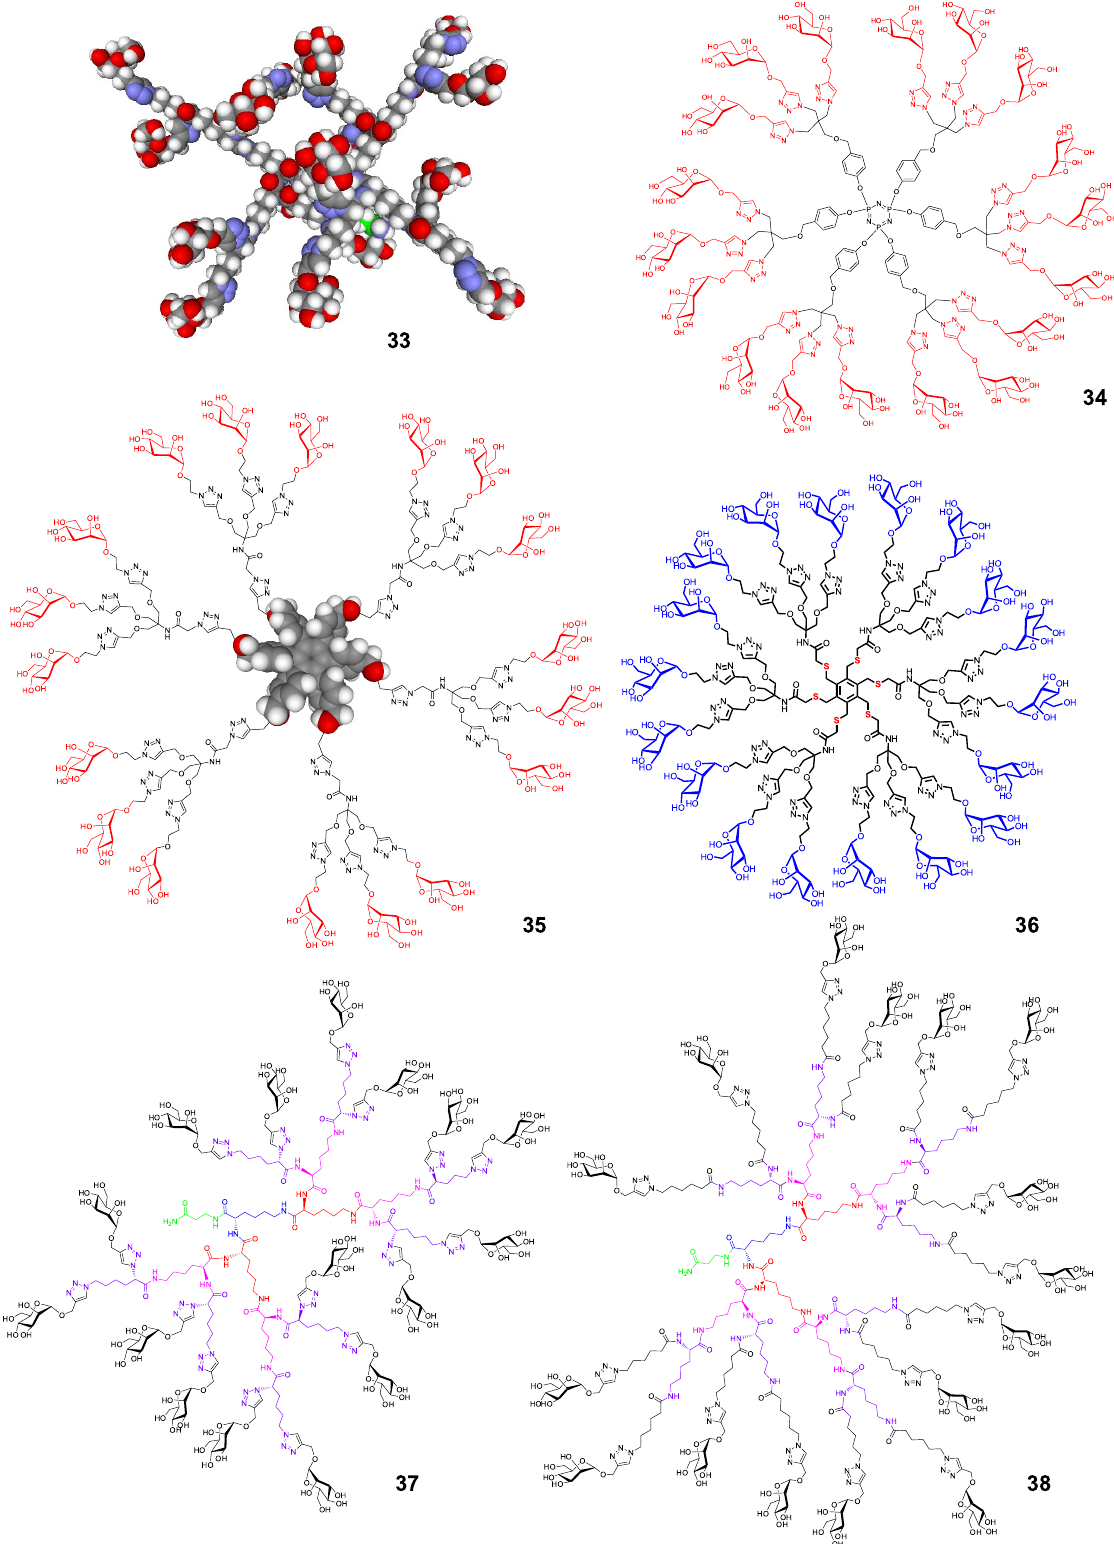
FIGURE 14 – Selected family members of glycodendrimers used against bacterial infections. Although they all harbour α -D- mannopyrannoside ligands against uropathogenic E. coli FimH; analogous scaffolds were used with different saccharides moities recognized by other bacterial